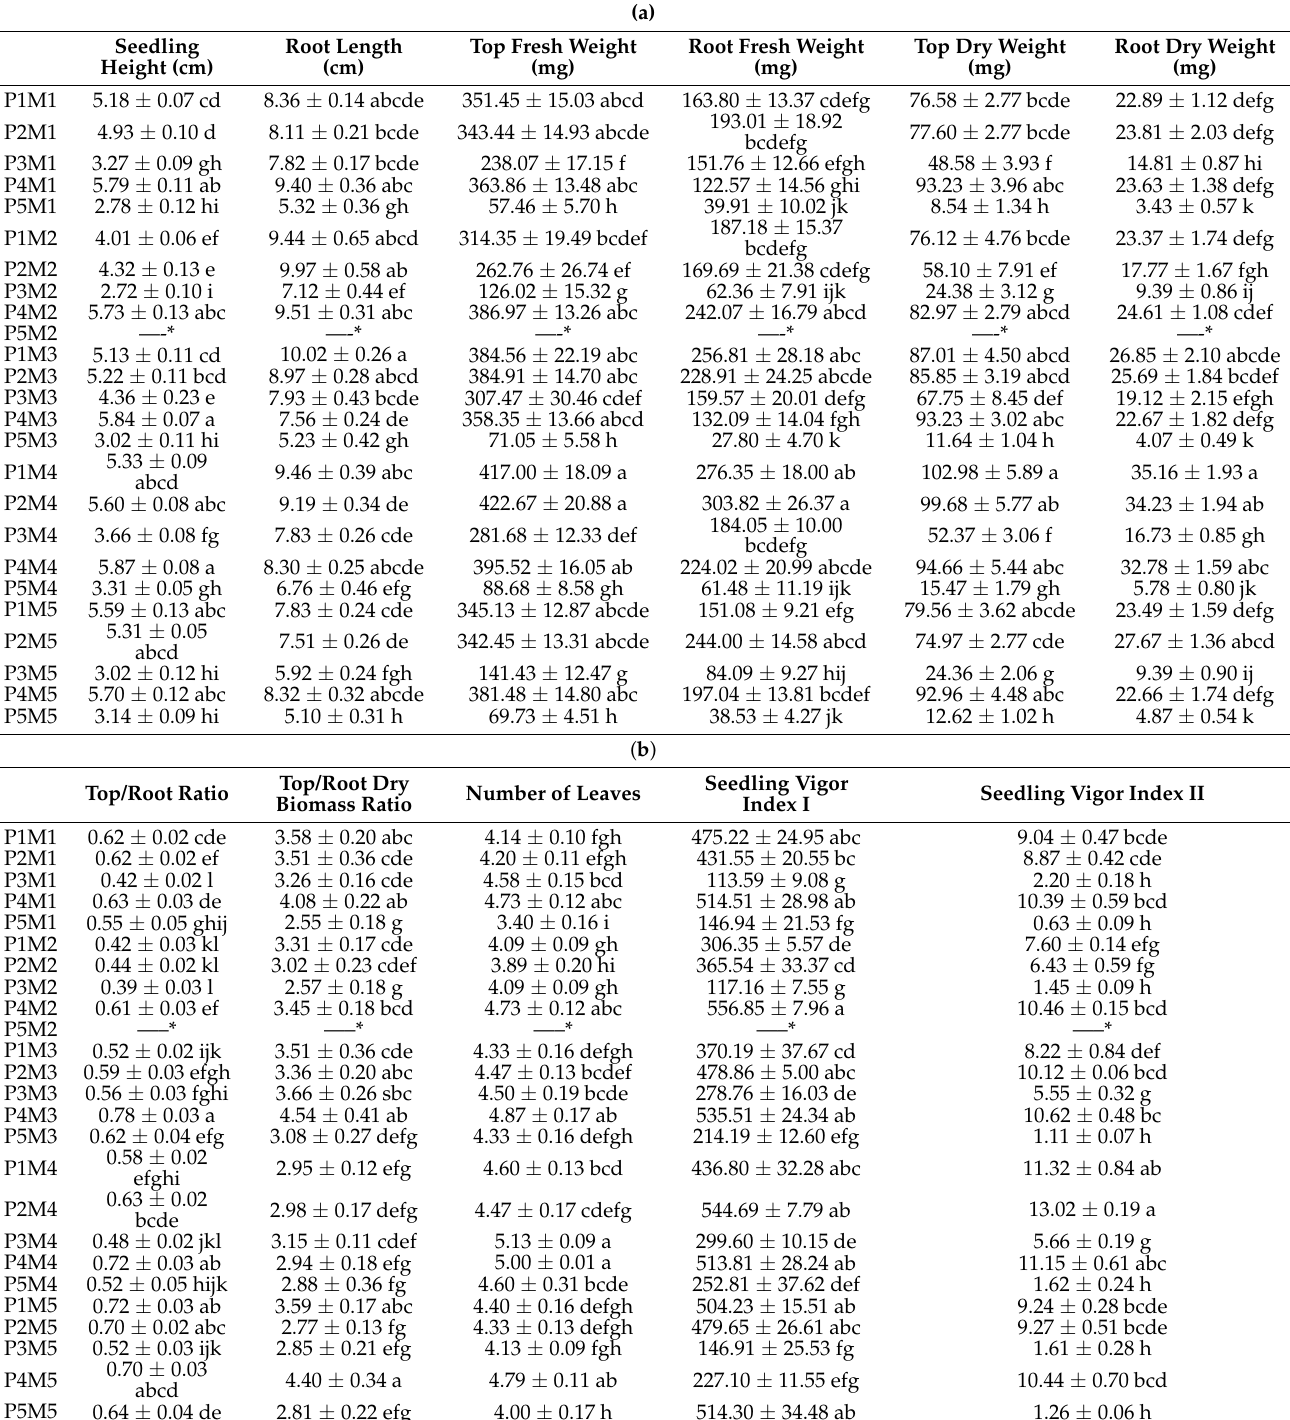
Table 3. ( a ) Interaction genotype (P) × priming method (M) for the seedling variables. ( b ) Interaction genotype (P) × priming method (M) for the ratios, indexes, and number of